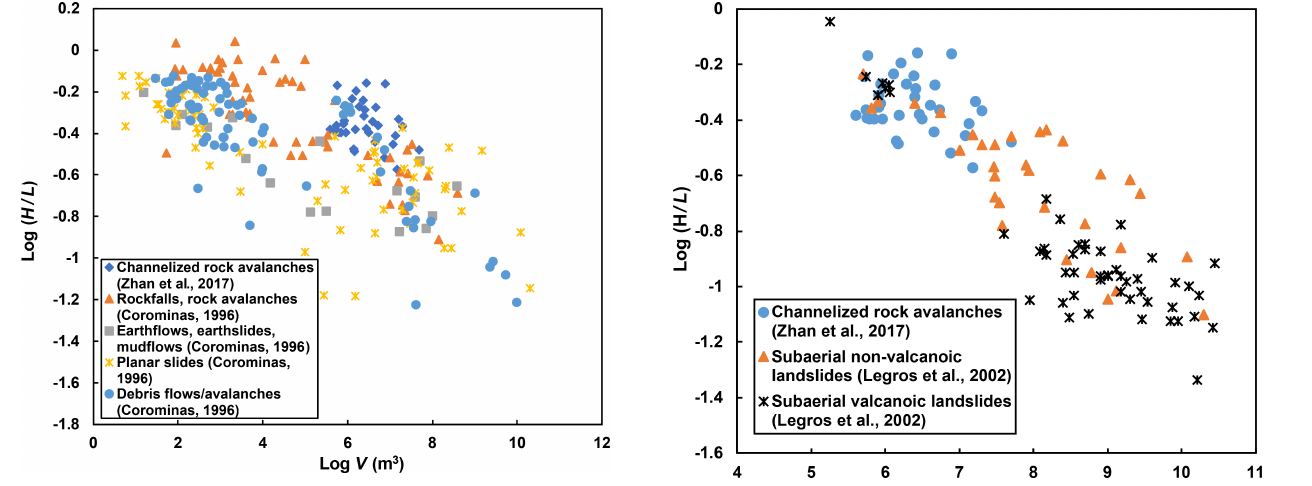
Figure 12. Relationship between the volume and H/L ratio of different-type landslides from the worldwide dataset (Corominas, 1996).